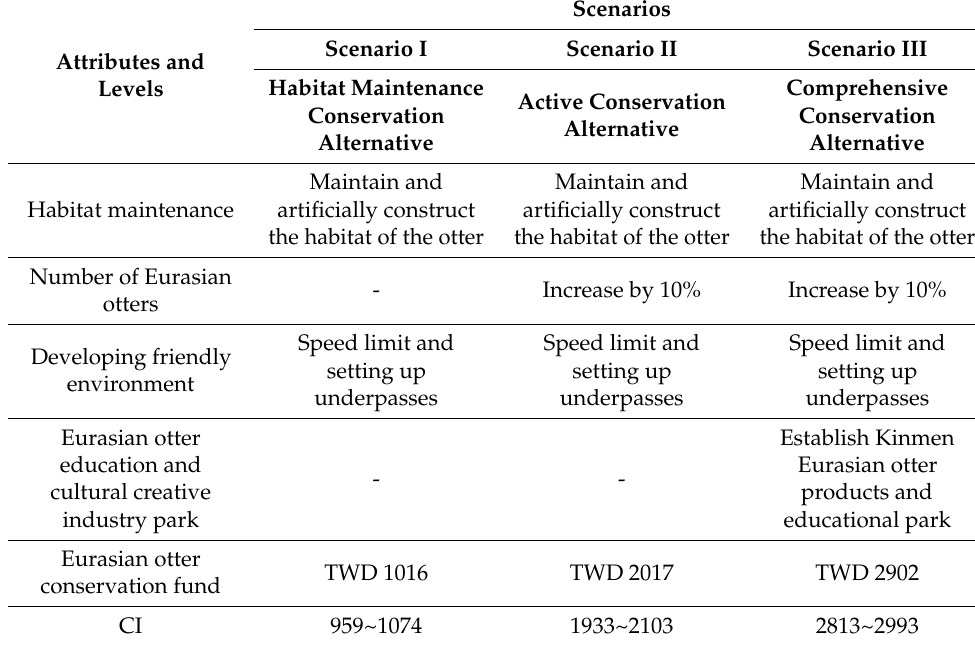
Table 5. Hypothetical strategies for the conservation of Eurasian